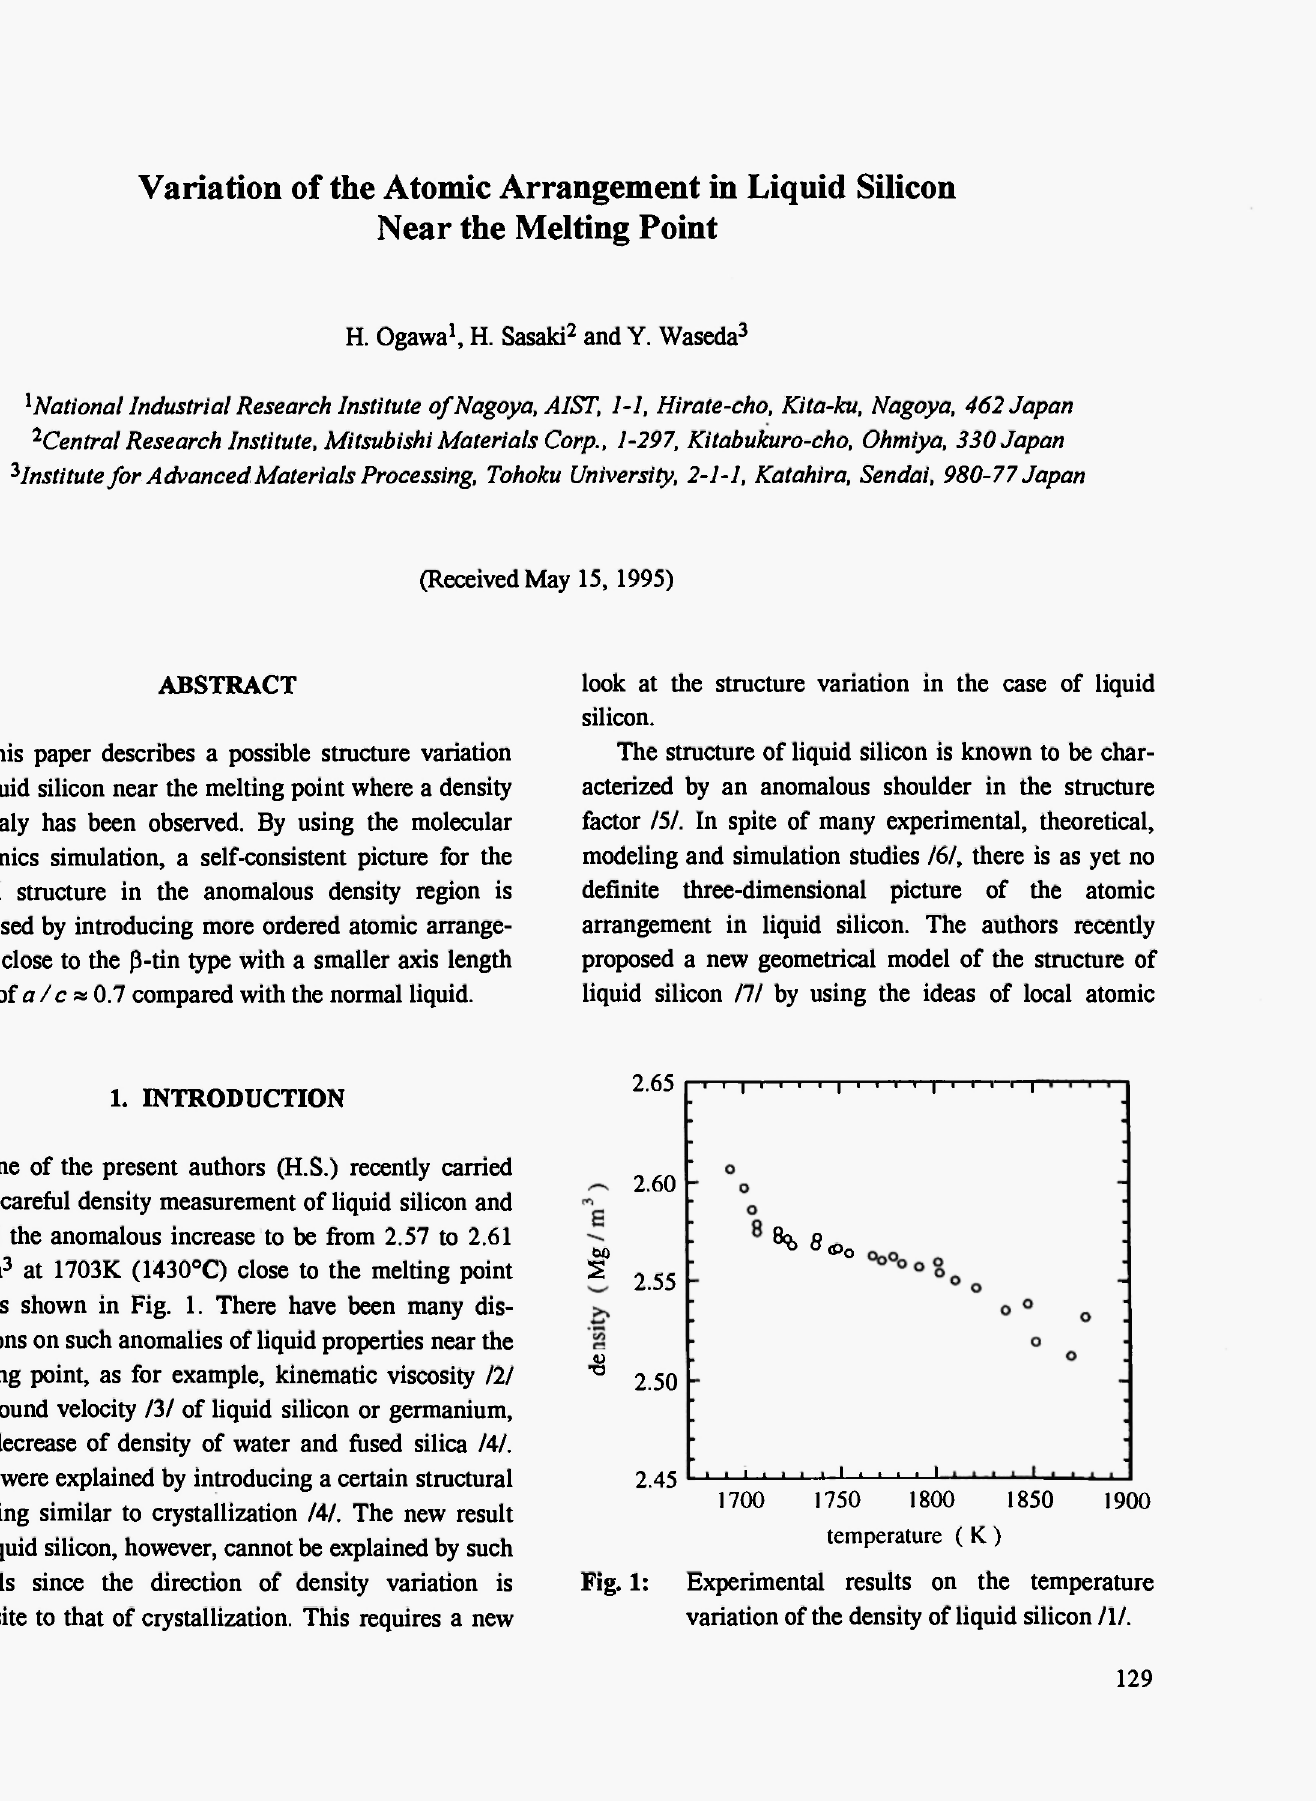
Fig. 1: Experimental results on the temperature variation of the density of liquid silicon